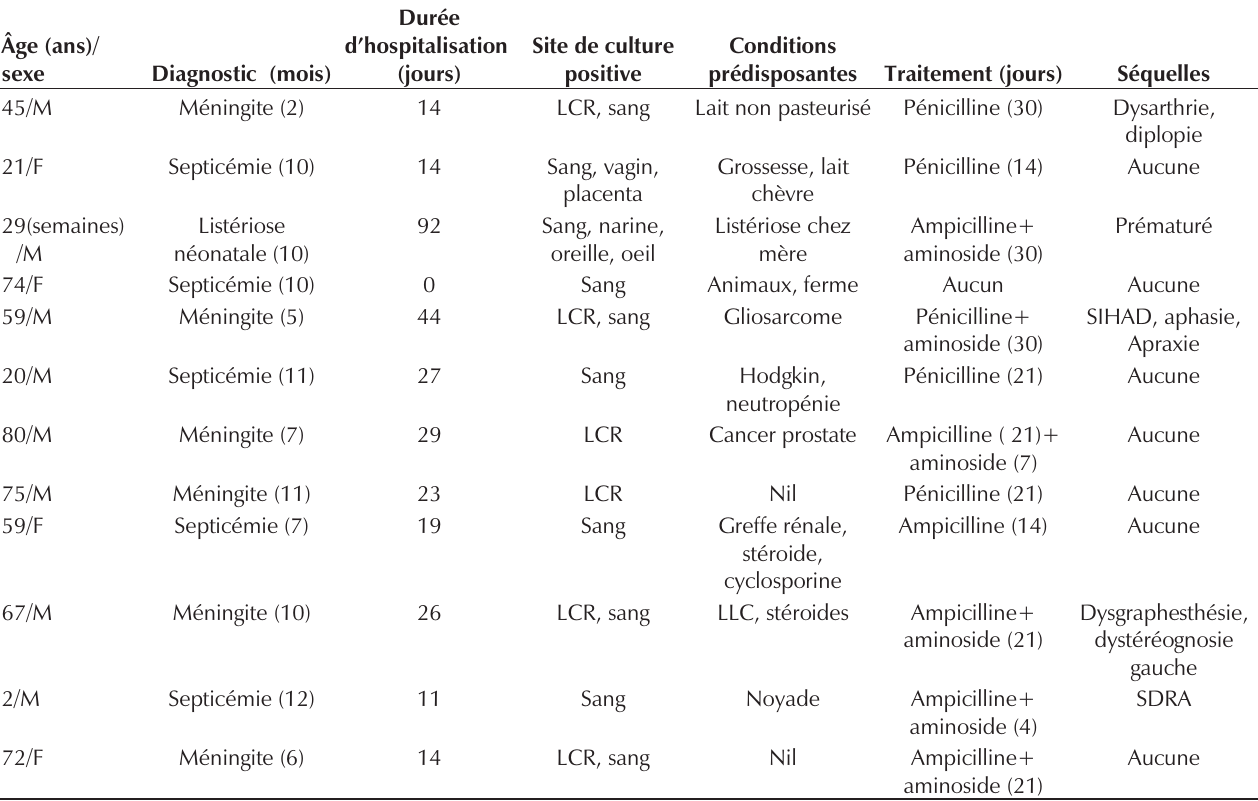
TABLE 1 Données sur 12 patients avec infection à Listeria monocytogenes en Estrie, Québec (1976-1995)